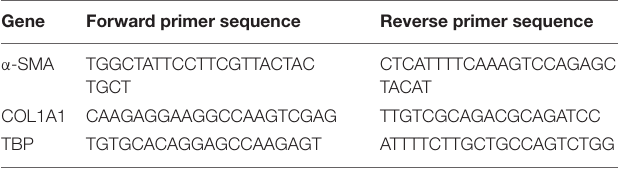
TABLE 1 | Primers used in qRT-PCR to evaluate gene expression.